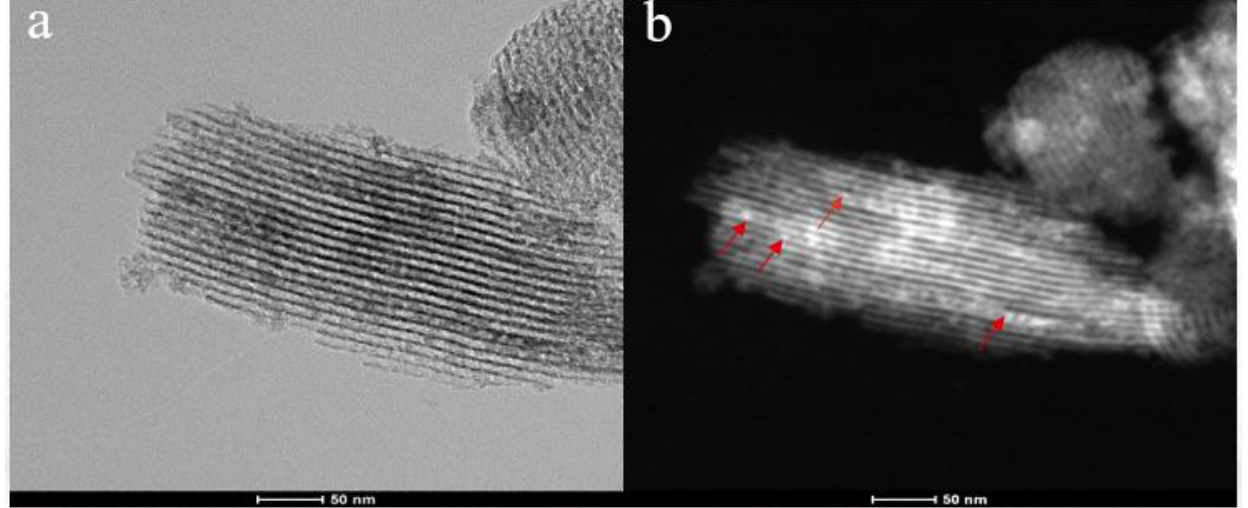
Figure 1. Typical ( a ) TEM and ( b ) HAADF-STEM images of Fe 2 O 3 /SBA-15.